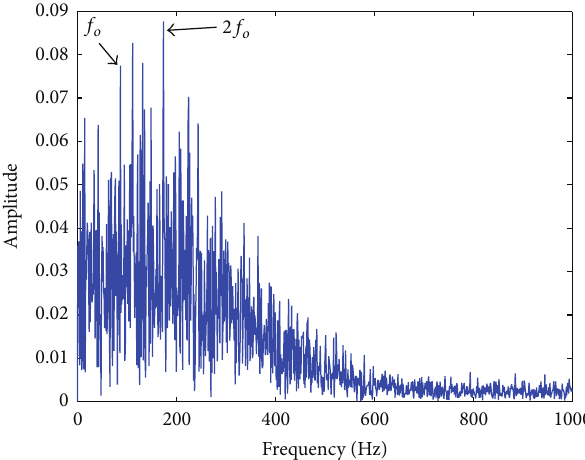
Figure 11: The decomposition results of